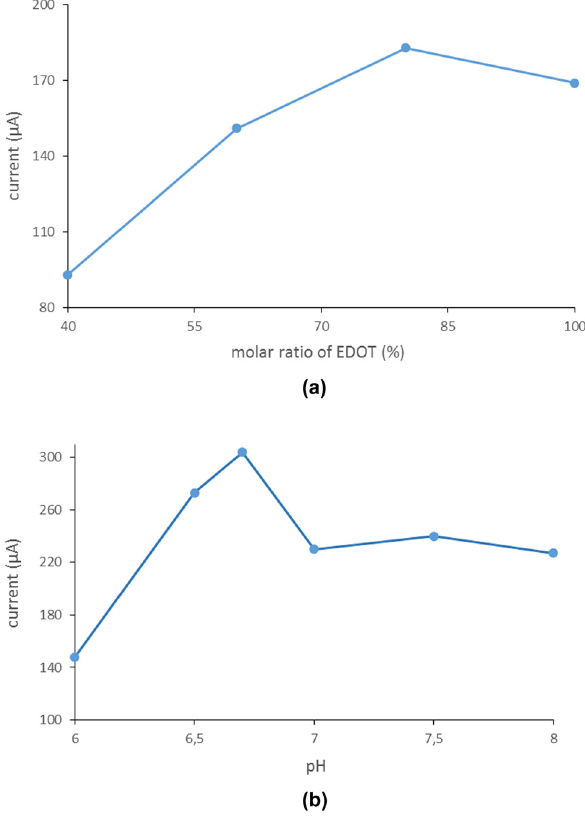
Figure 7: ( a ) E ff ect of the EDOT molar ratio on the response of the enzyme electrode. ( b ) E ff ect of pH on the response of the enzyme